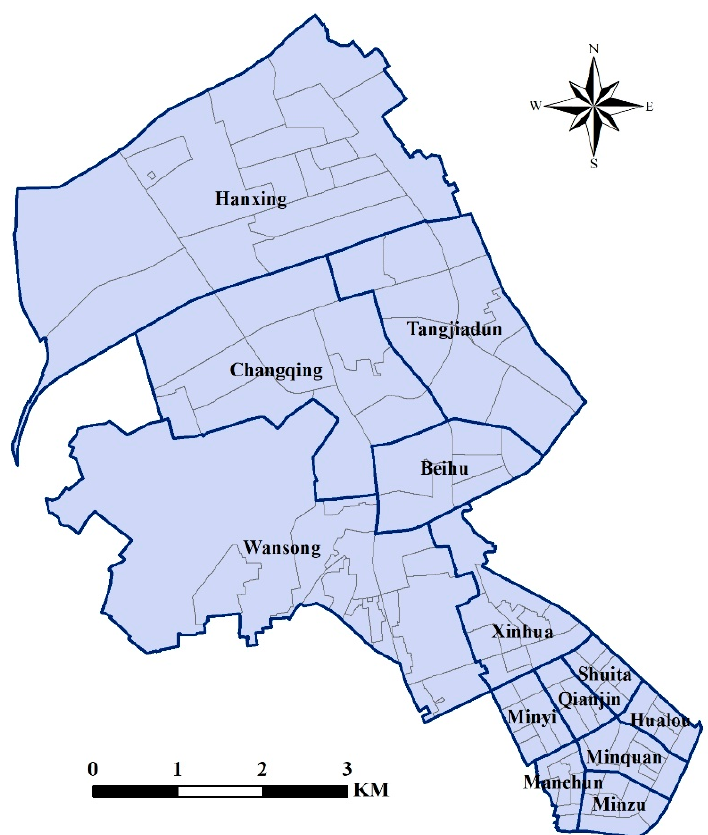
Figure 1. The sub-districts and neighborhoods in Jianghan.